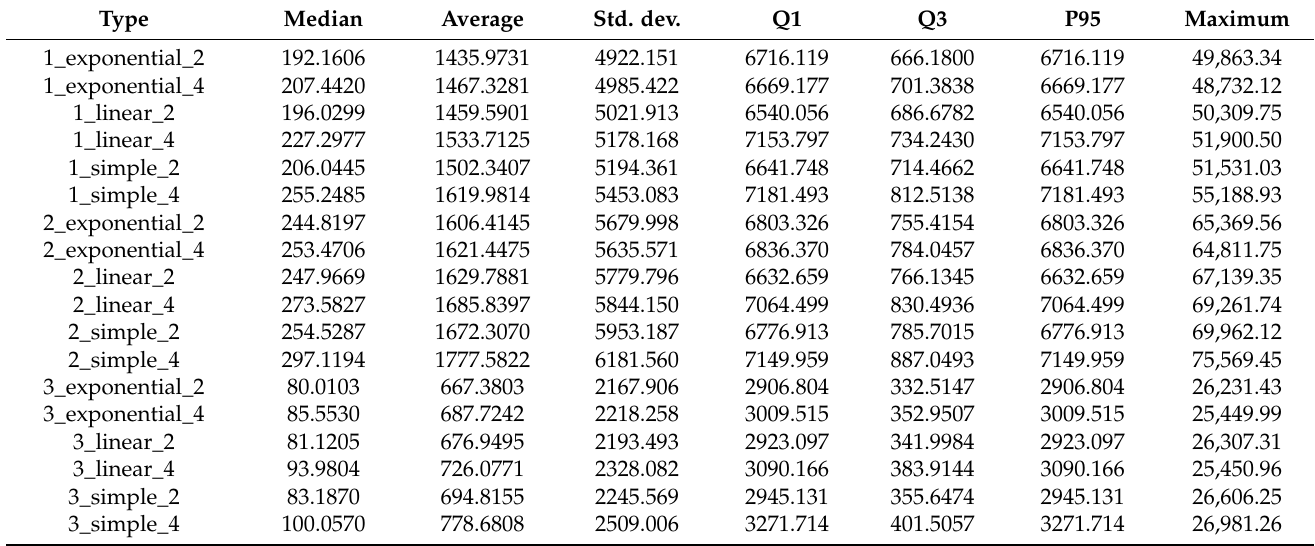
Table 5. MAE statistics for the first set of missing data (1—single).